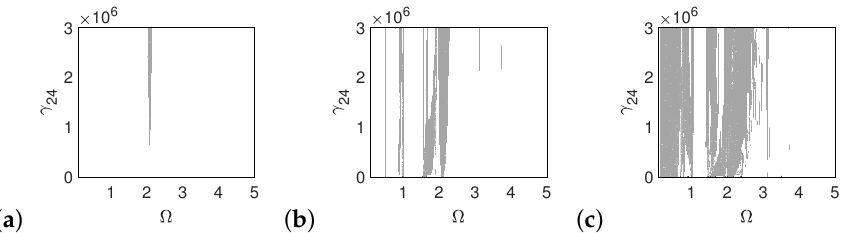
Figure 14. Regions of polyharmonic vibrations of the stapes in case of the pathological ear versus the nonlinear stiffness rate of the coupler ( γ 24 ) and the excitation frequency ( Ω ) under excitations of p ( a ), 5 p ( b ) and 10 p ( c ).